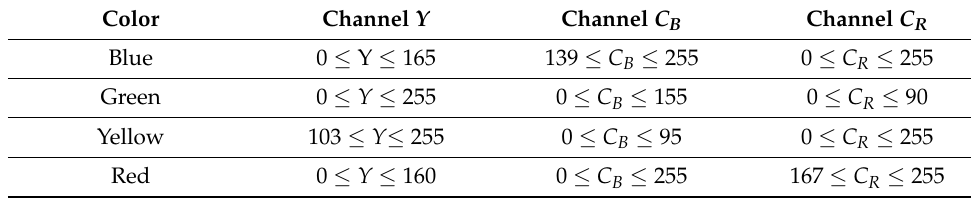
Table 1. YCBCR base color thresholding for blue, green, yellow, and red.